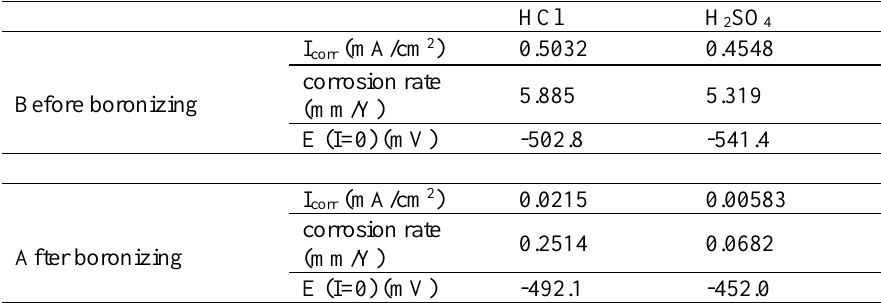
Table 2. Summary of the results obtained from corrosion tests of X52 steel performed in HCl and H 2 SO 4